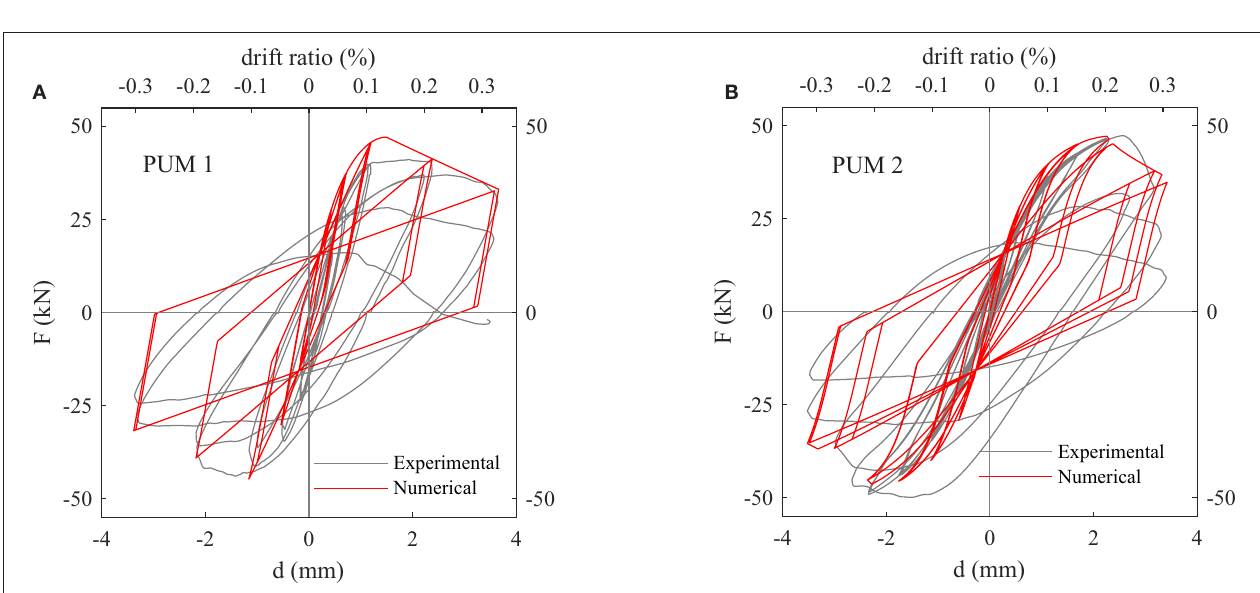
FIGURE 10 | Mixed RC/URM building: (A) test prototype on the shaking table, and (B) equivalent frame model of the building.